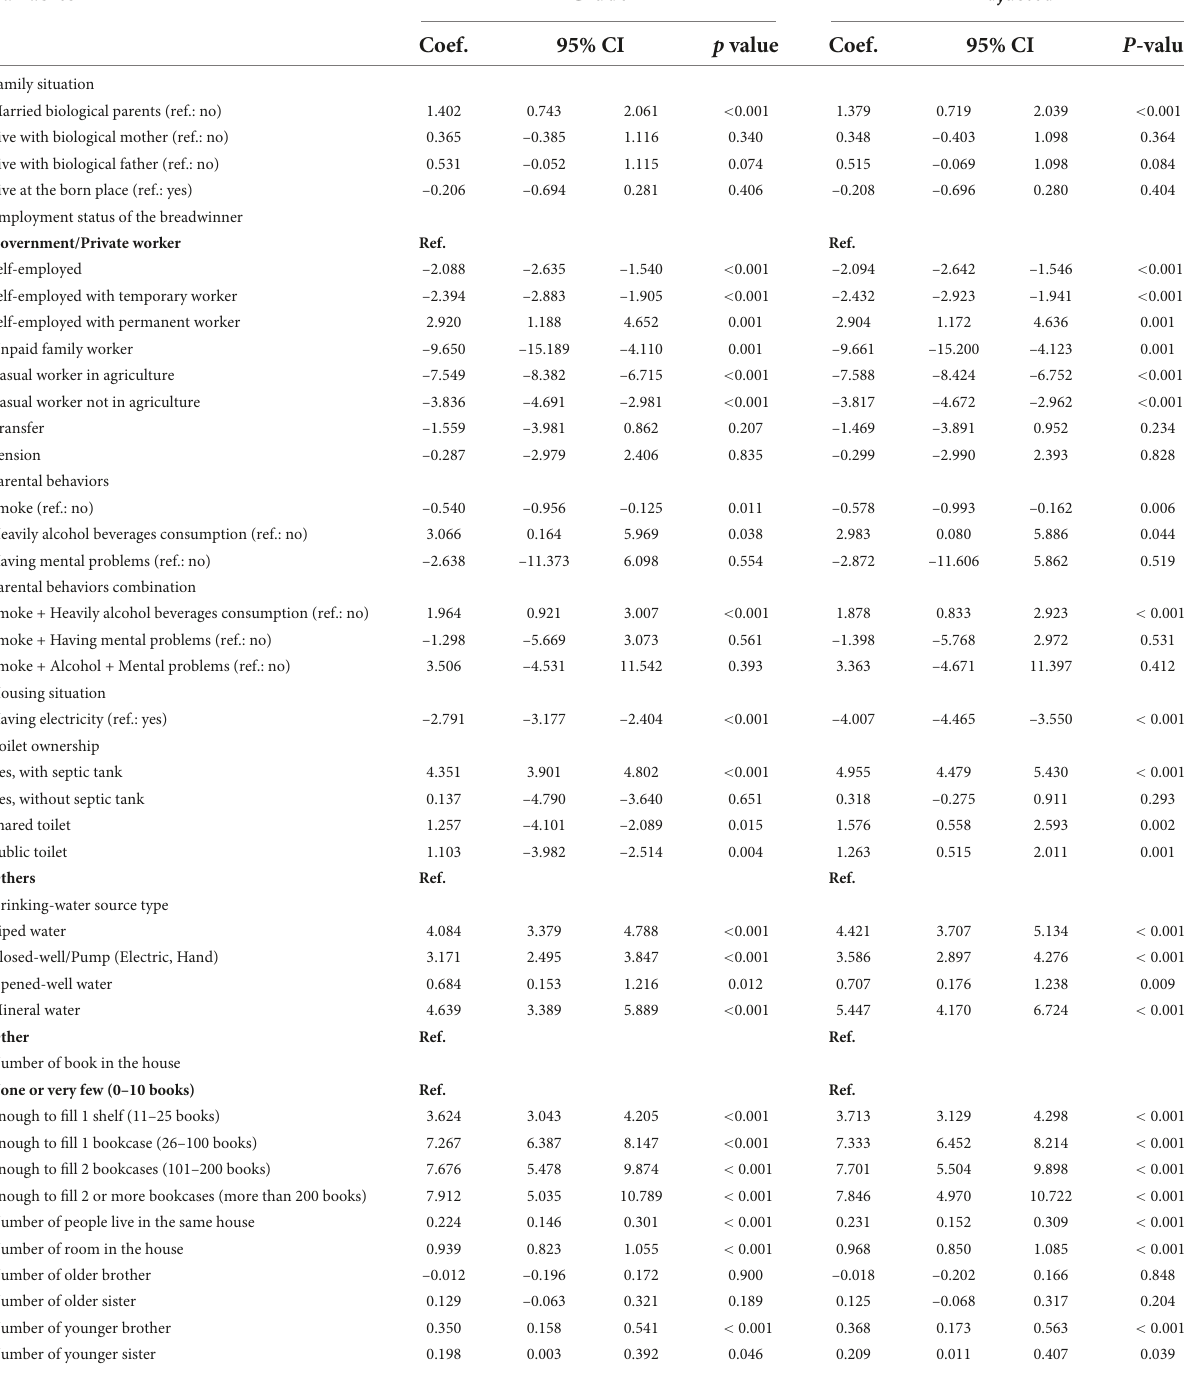
TABLE 3 Regression model of the association between childhood socioeconomic status and outcome.